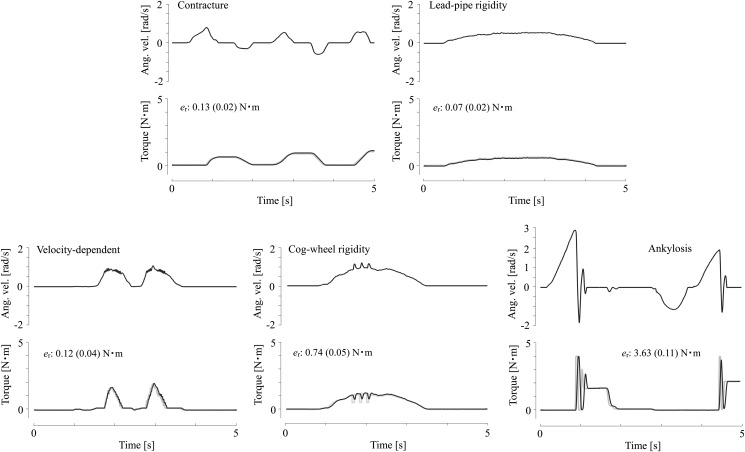
Sample resistance torques and knee angular velocities of the five types of simulated symptoms.The black and gray curves respectively represent the measured and set torques. e
r indicates the maximum and mean errors between the two values. Overall, the measured torques are in adequate agreement with the set values.